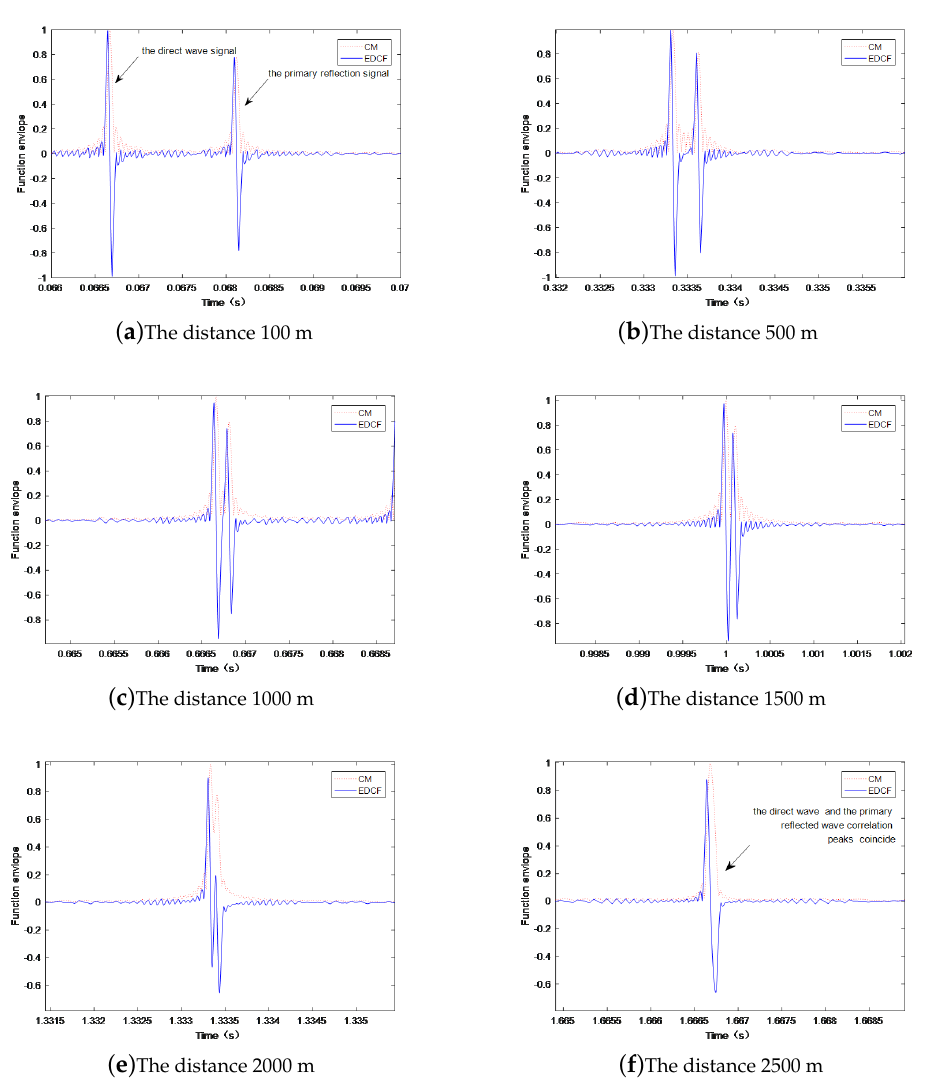
Figure 6. The anti-multipath channel performance of the